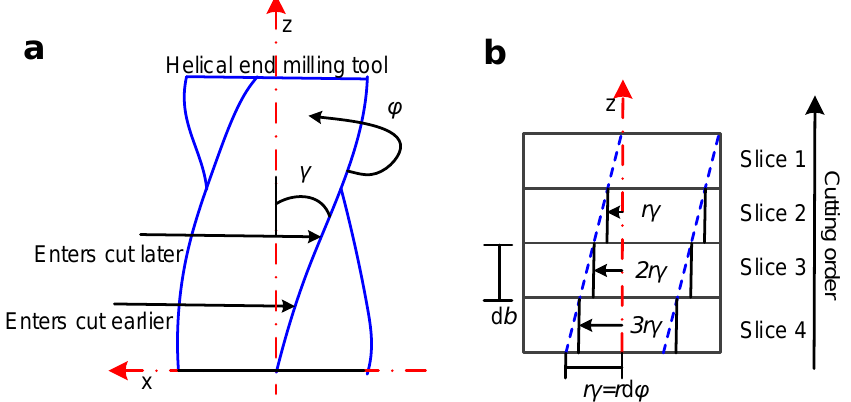
Figure 2. ( a ) Helical end milling tool geometry causing cutting edge time delay; ( b ) discretized version of unrolled helical end milling tool geometry.